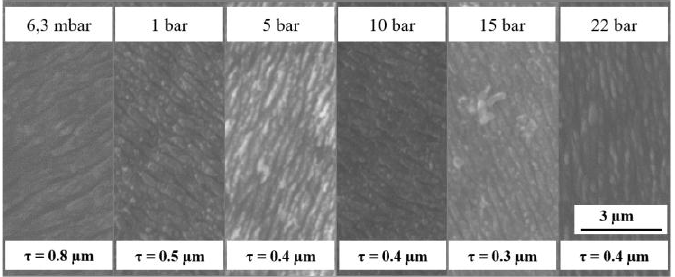
Fig. 2. The result of surface treatment of a titanium sample at various values of gas pressure, where τ is the period of LIPPS